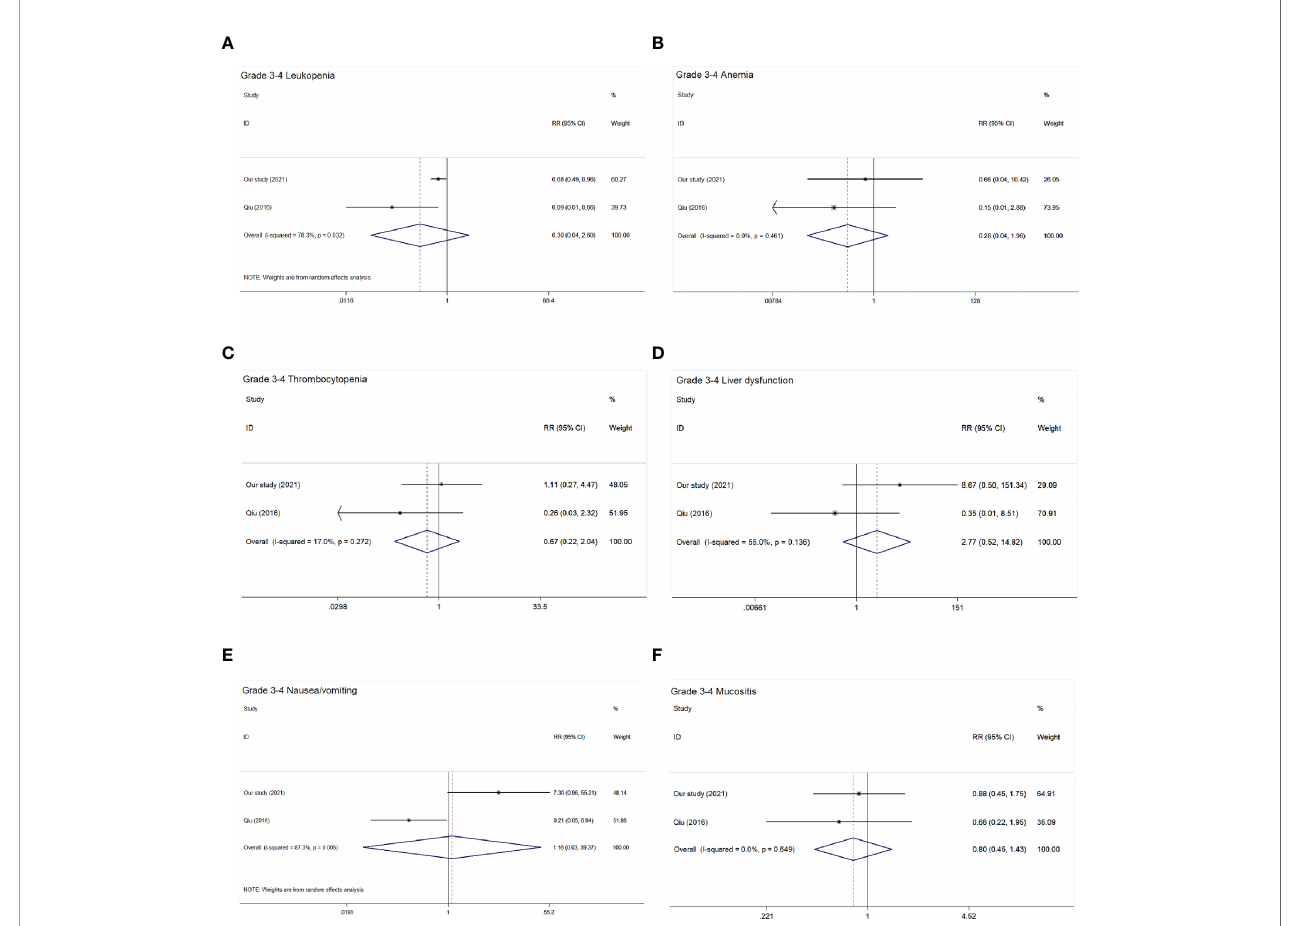
FIGURE 5 | Forest plot of grade 3 – 4 acute toxic effects of the included studies. (A) Grade 3 – 4 leucopenia; (B) Grade 3-4 anemia; (C) Grade 3 – 4 thrombocytopenia; (D) Grade 3 – 4 liver dysfunction; (E) Grade 3 – 4 nausea/vomiting; (F) Grade 3 – 4